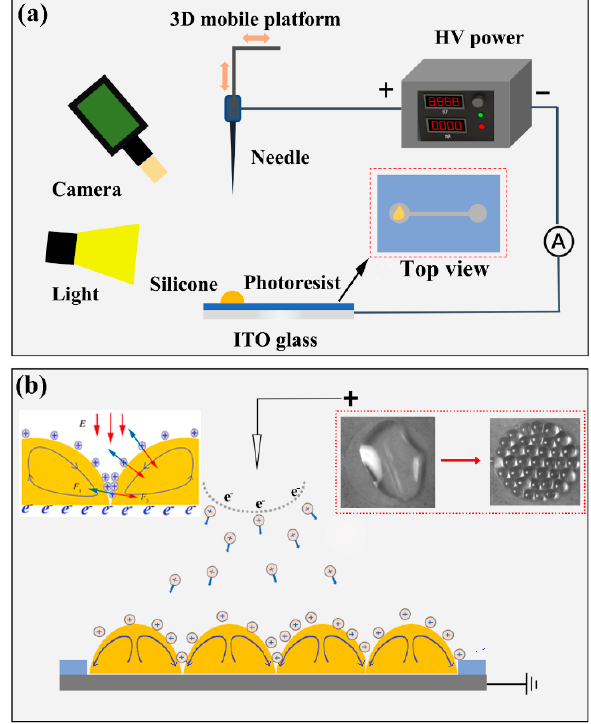
Figure 1. Experimental setup and formation principle of dielectric droplets by ion wind. ( a ) Schematic diagram for the experimental setup. ( b ) Formation principle of dielectric droplets.